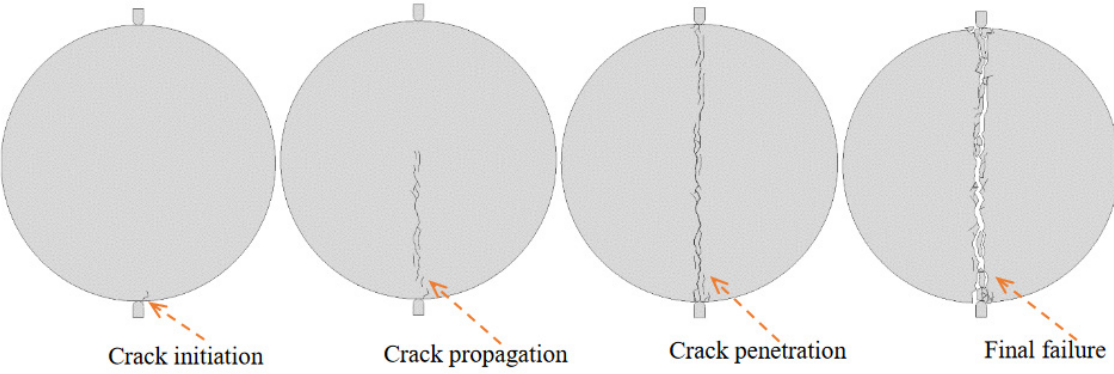
Figure 8. Failure process for the Type I Brazilian disc testing.